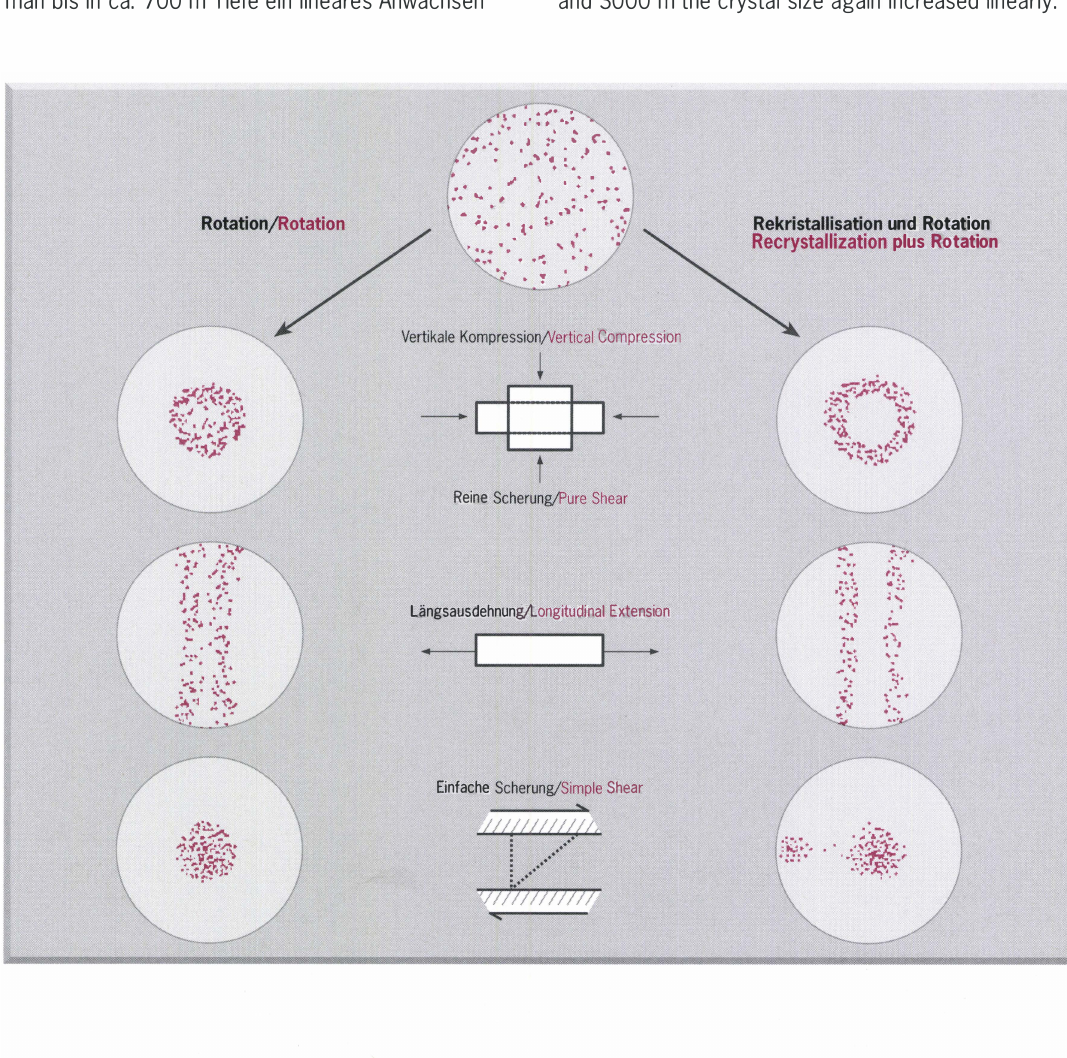
Fig.9: Texture development in polar ice masses under various types of loading. For the c-axis distribu­ tion one obtains a different diagram when recrystallisation is taken into account. (from Alley, 1992, with